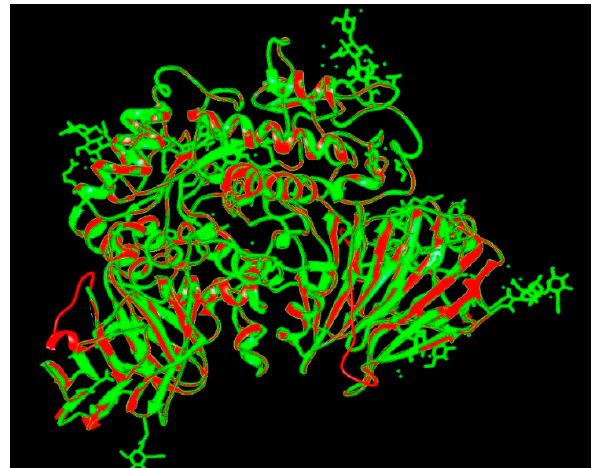
Figure 1. Superposition of target (red) and template (green).